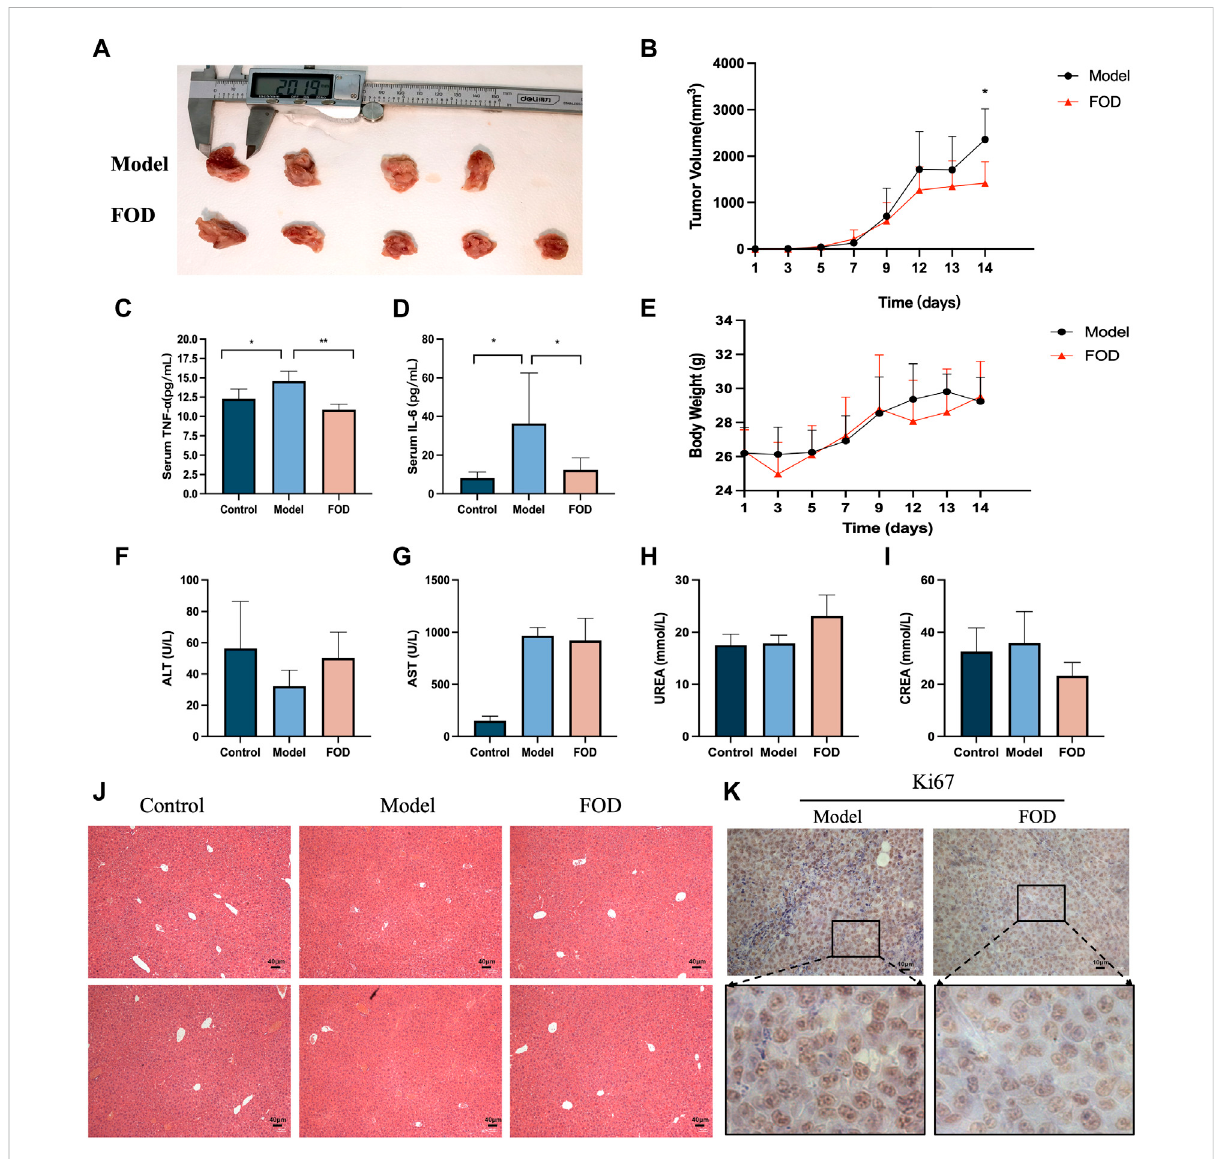
FIGURE 1 The inhibitor effects of FOD on the proliferation of HCC subcutaneous tumors. (A) Image of HCC subcutaneous tumors in model group and FODgroupareshown.H22cellswereinoculatedintoBALB/C-numice,andthemicewererandomlydividedintotwogroupsformodelgroup(saline i.p)and FODgroup (0.4 mg/kg/d i.p). (B) Tumor volume ofmiceinmodelgroup and FODgroup atdifferenttime points. (C,D) Expression ofIL-6 and TNF- α inbloodofmiceincontrolgroup,modelgroupandFODgroup. (E)